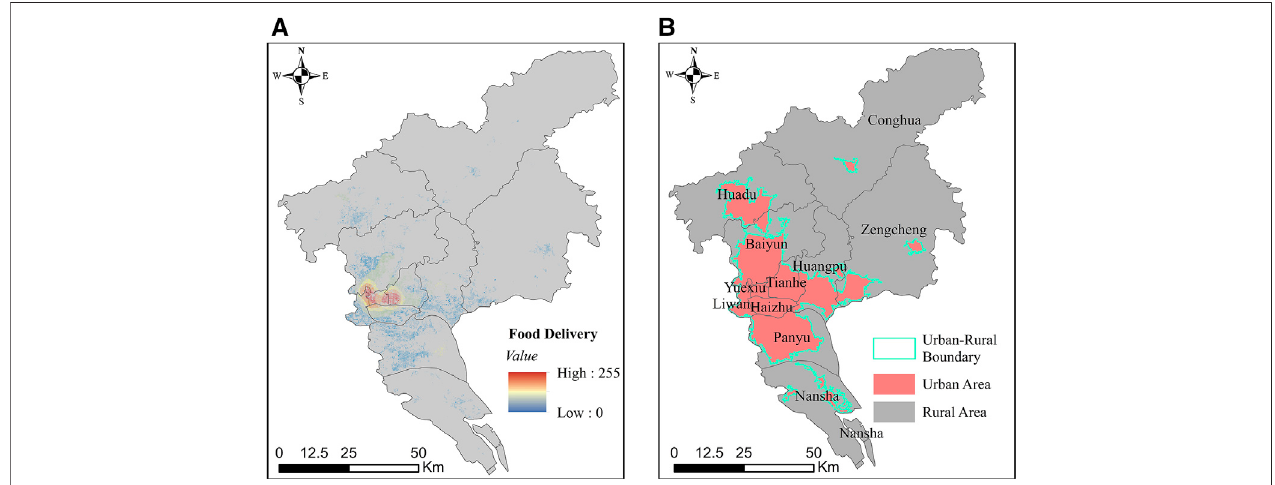
FIGURE 5 | (A) The urban and rural spatial range to which food can be delivered; (B) Urban and rural areas identi fi ed by food delivery data (The urban and rural spatial area identi fi ed by food delivery data is shown in the fi gure, among which, (A) is the range of deliverable food and (B) is the identi fi ed urban and rural spatial area).